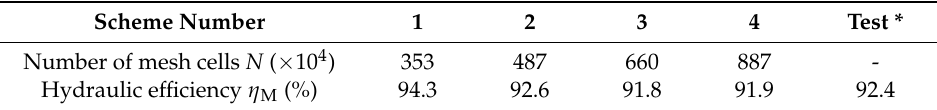
Table 2. Dependency analysis for the number of mesh